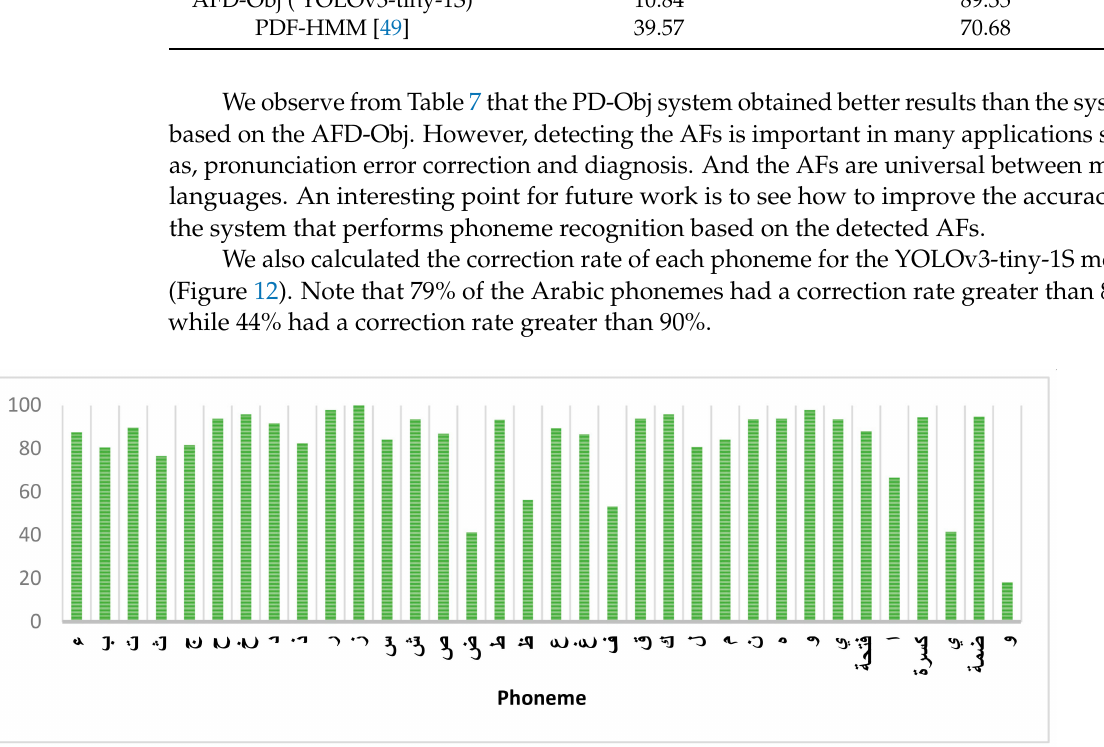
Figure 12. Correction rate of an Arabic phonemes using YOLOv3-tiny-1S